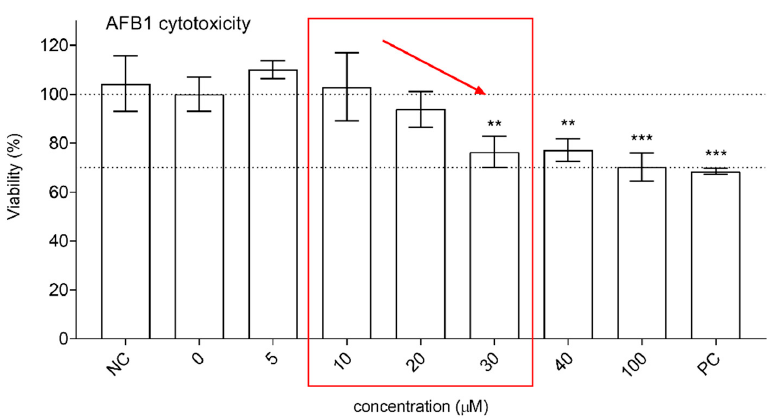
Figure 4. The effects of AFB1 (5–100 μ M; 24 h exposure) on the viability of HepG2 cells (MTS assay) expressed in percentage of the solvent control (0; 1% DMSO—upper dashed line). NC is the negative control (growth medium). PC is the positive control—ET (25 μ g/mL). The lower dashed line represents the 30% viability threshold. The asterisks (*) denote statistically significant differences (ANOVA and Dunnet’s multiple comparison test) between the solvent control and the AFB1 exposed cells (** p ≤ 0.01; *** p ≤ 0.001). The selected concentration range for further experiments is marked by the red square.